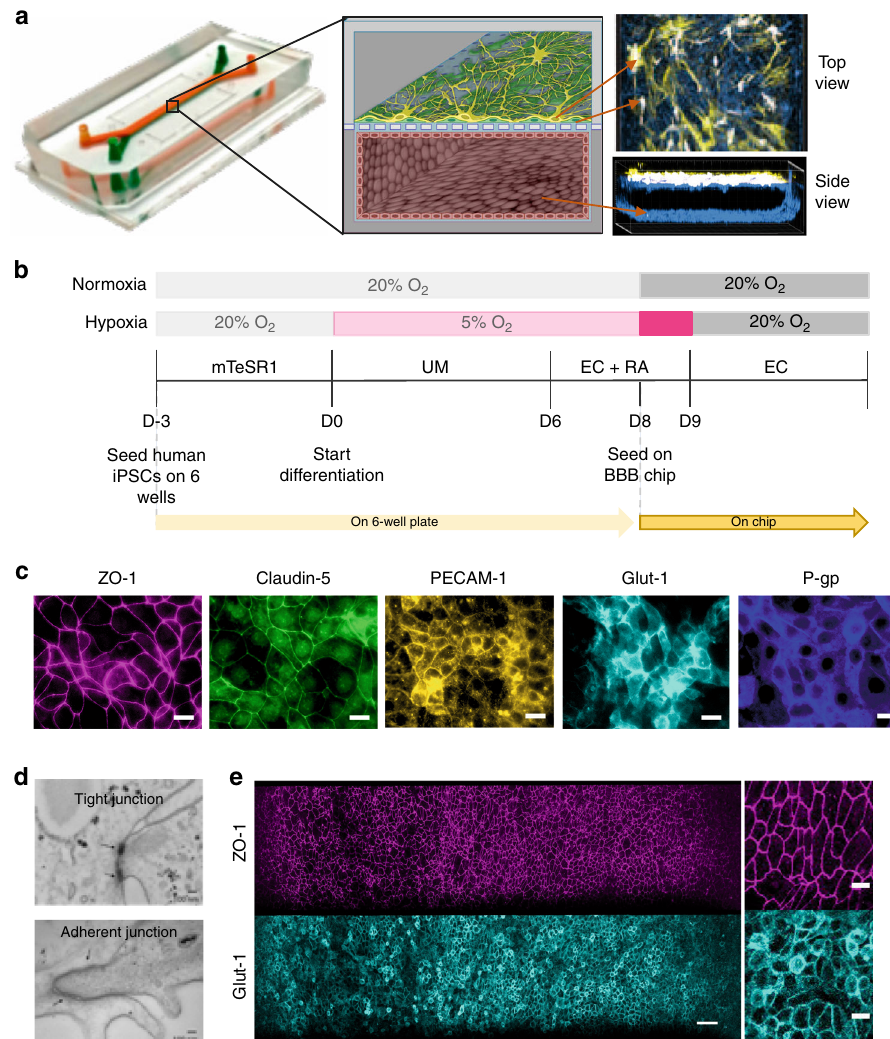
Fig. 1 Reconstitution of the human BBB in an Organ Chip micro fl uidic device. a Photograph (left), schematic illustration (center), and immuno fl uorescence micrographs (right) of a 2-channel micro fl uidic Organ Chip with iPS-BMVECs cultured on all surfaces of the basal vascular channel, and primary human brain astrocytes and pericytes on the upper surface of the central horizontal membrane in the apical parenchymal channel. At the top right, z-stack images of the pericytes (yellow, F-actin staining) and astrocytes (white, GFAP staining) in the top channel of the BBB Chip are reconstituted and shown from above; a side view of similar stacked images for the lower vascular channel containing BMVECs (blue, ZO-1 staining) is shown at the bottom right. A video of overlay z-stack reconstituting this 3D BBB can be seen in Supplementary Movie 1. b Timeline for the in vitro differentiation of the human iPS-BMVECs, and seeding in the BBB Chips. c Immuno fl uorescence micrographs of the human brain endothelium cultured on-chip for 3 days labeled with ZO-1, Claudin- 5, PECAM-1, GLUT-1, and P-glycoprotein (bar, 20 µ m). d Electron micrographs of the human brain microvascular endothelium after 3 days in the BBB Chip, highlighting the presence of well-formed tight junctions (top, arrow) and adherens junctions (bottom, arrow) (bar, 100 nm). e Low (left) and high (right) magni fi cation immuno fl uorescence micrographic views of the human brain microvascular endothelium cultured on-chip for 3 days viewed from above demonstrating high levels of expression of ZO-1 and GLUT-1 across the entire endothelial cell monolayer (bar, 50 µ